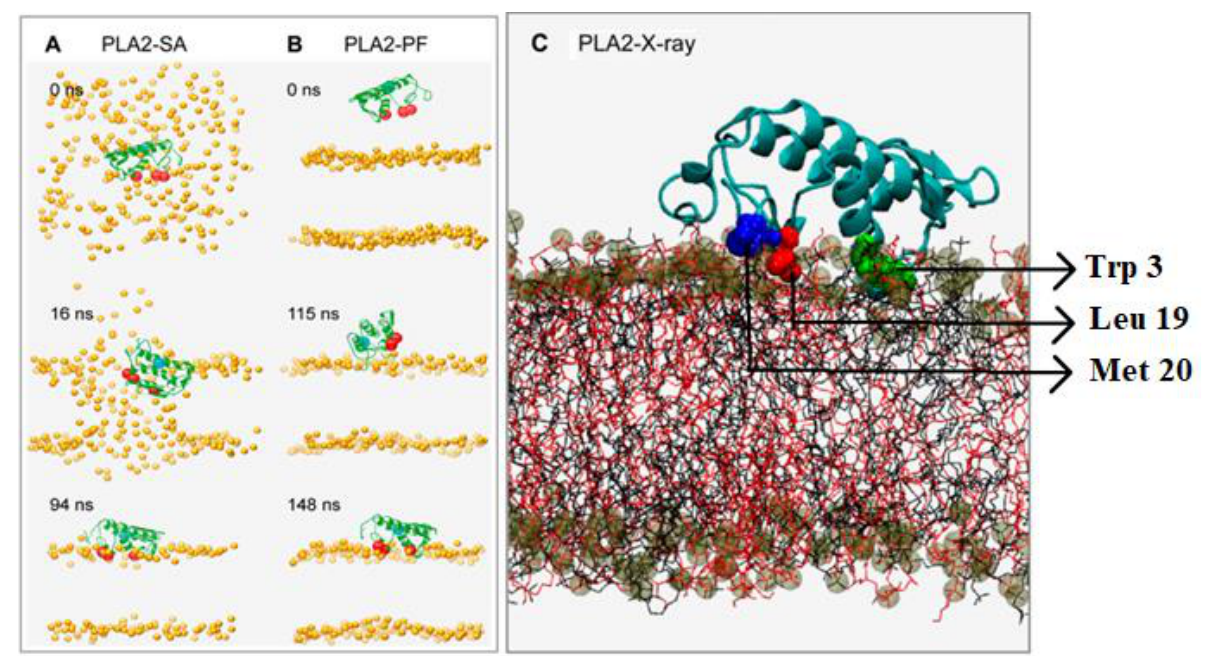
Figure 6. Snapshots from the CG-MD simulations at different timeframes: ( A ) sPLA2-SA (self-assembled simulation); ( B ) sPLA2-PF (preformed simulation). The backbone of the enzyme is shown in green; the hydrophobic anchoring residues are shown in red; and the active site residue (H48) is depicted as a blue sphere; ( C ) snapshot of atomistic MD simulation of sPLA2 (PLA2-X-ray) on phospholipid bilayer. The protein backbone is depicted in light blue, and the three hydrophobic residues Trp-3, Leu-19 and Met-20 are colored in green, red, and deep blue, respectively, in a space-filling model. Reprinted/adapted with permission from [22]. Copyright 2008, Elsevier.